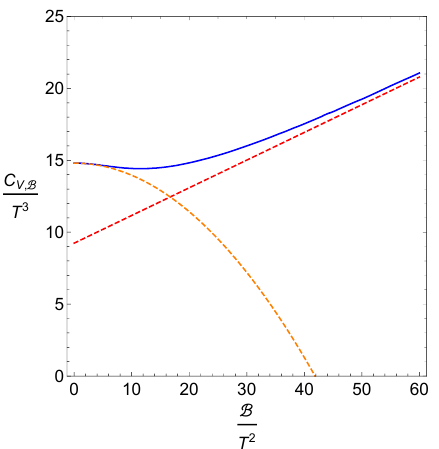
Figure 7 . Dimensionless specific heat C V, B /T 3 (solid) as a function of b = B /T 2 (solid blue line), compared with the analytical solutions at small b (orange dashed line) and large b (red dashed